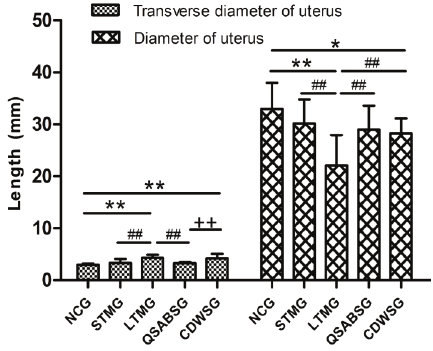
Figure 4. Changes of transverse diameter and diameter of uterus after modeling. Data are reported as means ± SD. *P o 0.05, **P o 0.01 compared with NCG; ## P o 0.01 compared with LTMG; ++ P o 0.01 compared with QSABSG (ANOVA). NCG: normal control group; STMG: short-term model group; LTMG: long-term model group; QSABSG: Qi stagnation and blood stasis group; CDWSG: combining disease with syndrome